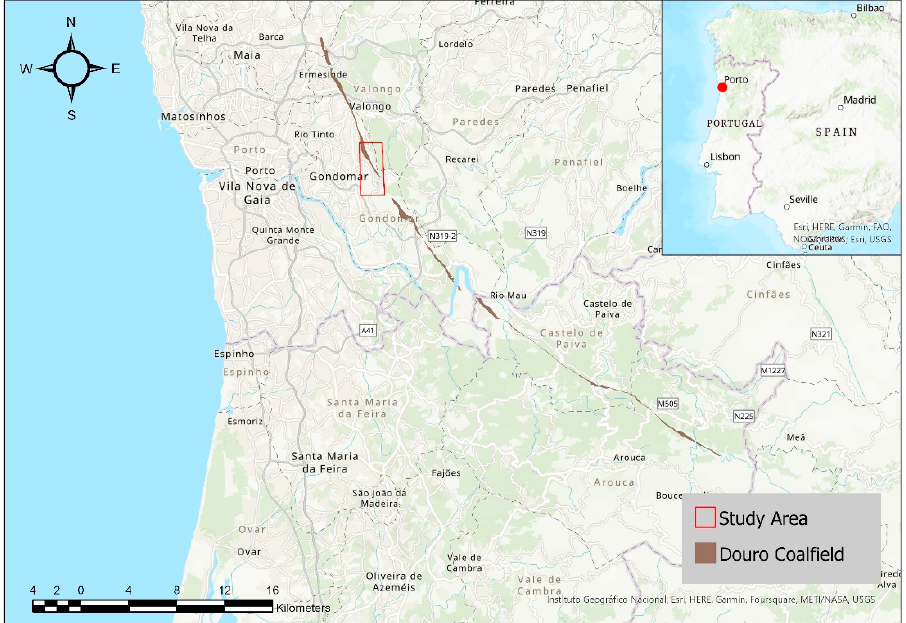
Figure 1. Geographical location of São Pedro da Cova coal waste pile.